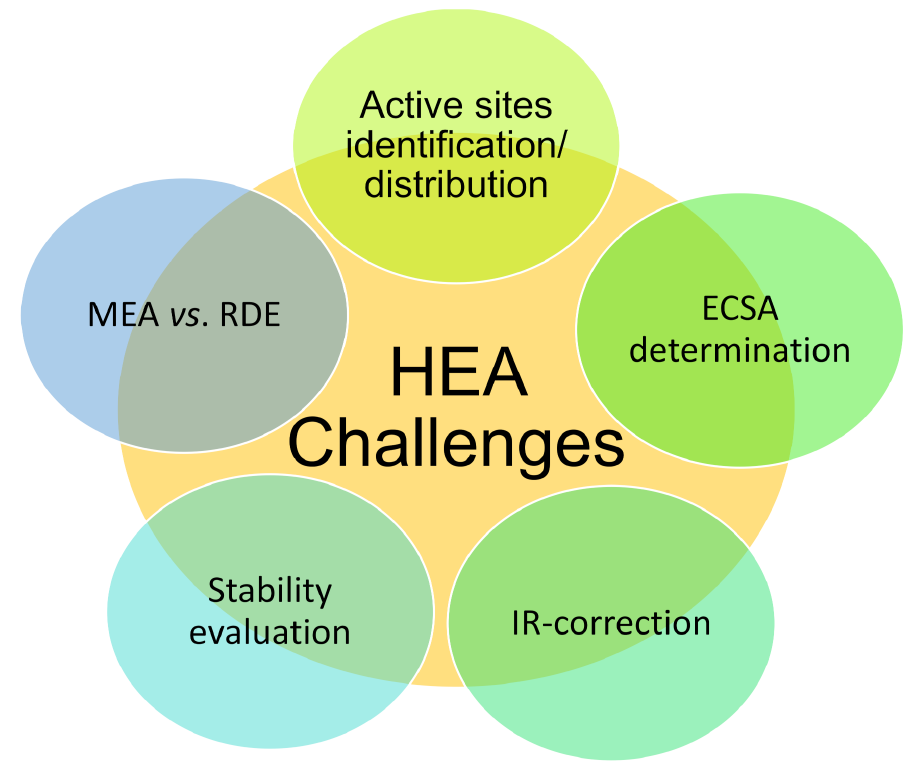
Figure 3. The mass activity of multicomponent alloys for ORR in 0.1 M HClO 4 or 0.1 M KOH. Mass activity for Pt/C commercial is shown in both media to facilitate